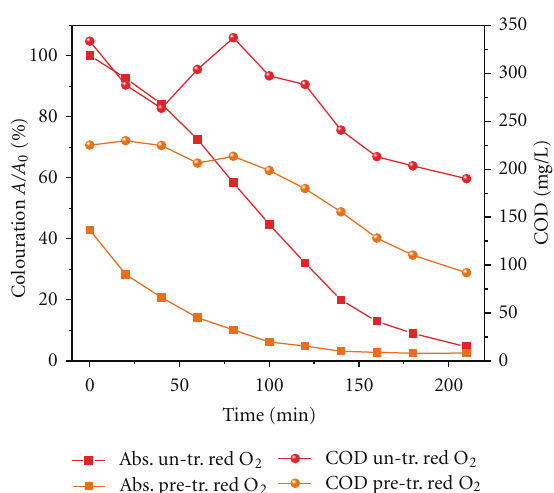
Figure 8: Colouration expressed as A/A 0 and COD values of Reactive Red 22 wastewater samples at di ff erent times of PCOx